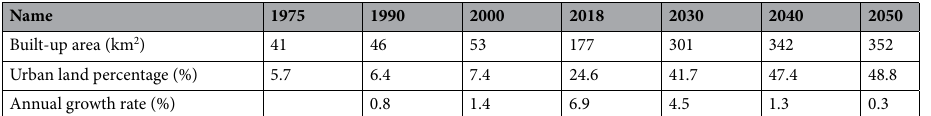
Table 2. Changes in Kathmandu Valley’s built-up areas over time. Annual growth rate = (cid:31)